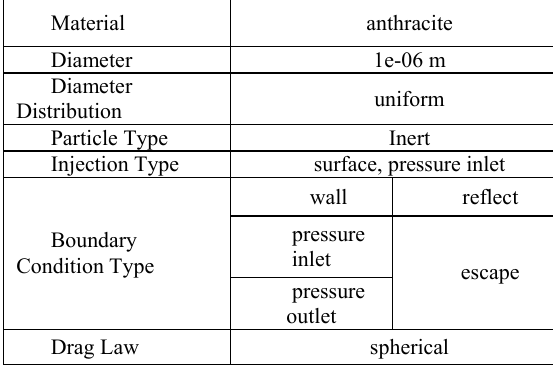
Tab. 1 Calculation network, simulation